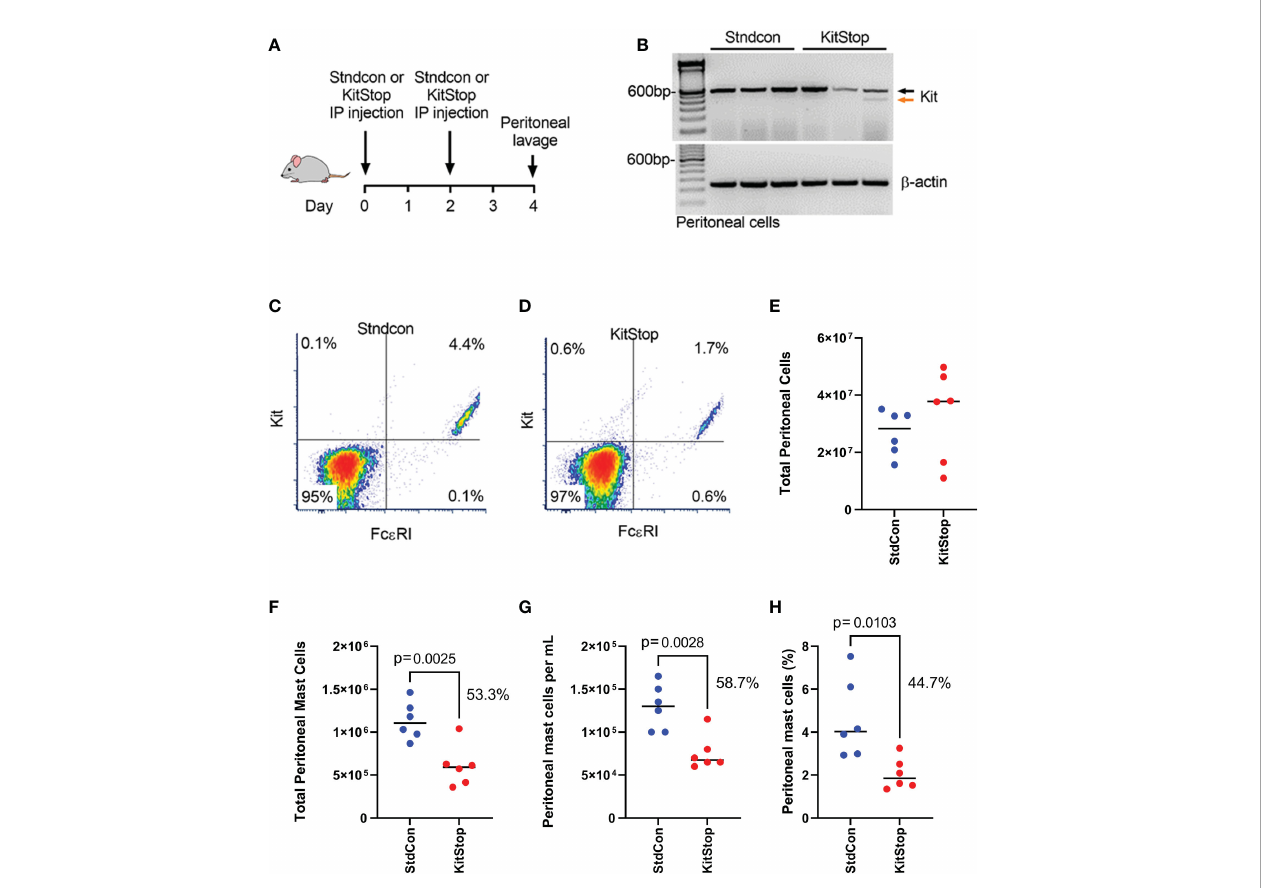
FIGURE 1 KitStop ESO reduces Kit expression in mouse mast cells locally in vivo . (A) Balb/c mice received 2 intraperitoneal injections of standard control ASO or KitStop ESO 2 days apart. A peritoneal lavage was performed 2 days after the fi nal injection, and cells in the lavage fl uid were analyzed for KIT and Fc ϵ RI expression. (B) RT-PCR of c-Kit expression in cells collected by peritoneal lavage (n=3). Black arrow = full-length c-Kit, orange arrow = alternatively spliced c-Kit. (C, D) Representative fl ow cytometry density plots of peritoneal cells harvested from seven mice treated with standard control ASO (C) or KitStop ESO (D) . (E) Total number of cells enumerated in the peritoneal lavage fl uid collected. (F) Total number of peritoneal mast cells in peritoneal lavage fl uid. (G) Number of mast cells per milliliter of peritoneal lavage fl uid recovered. (H) Percent of mast cells out of all cells recovered from